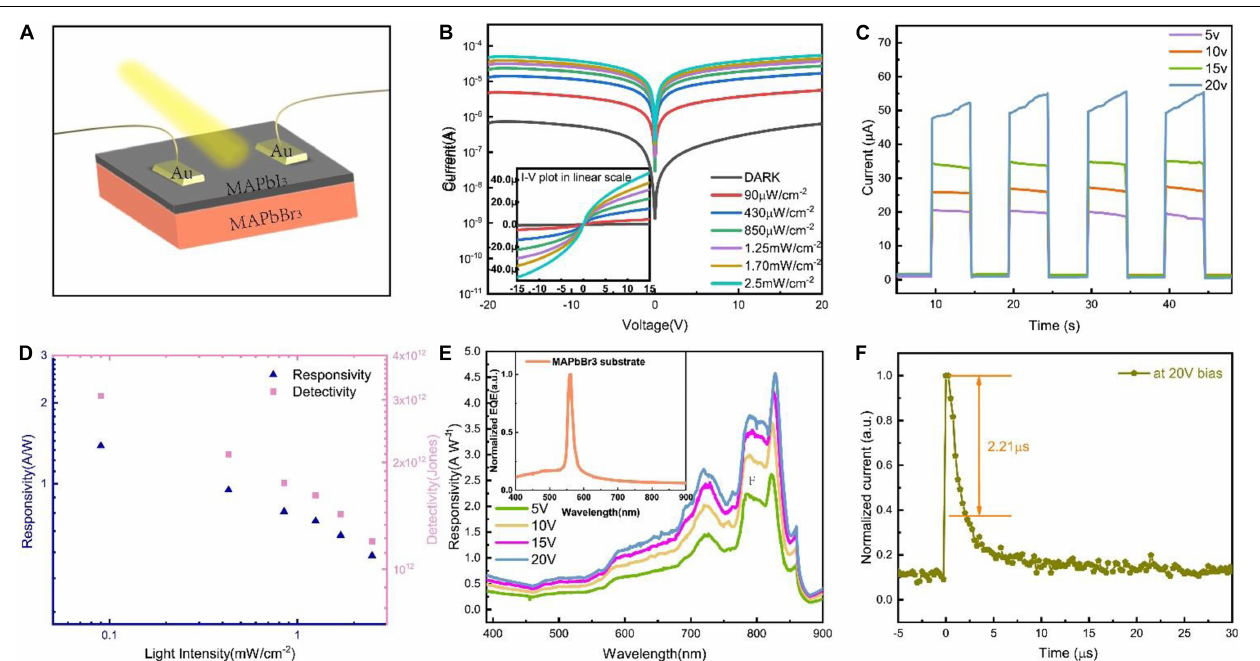
FIGURE 3 | (A) Schematic illustration of our photodetector and the incident light. The size of the photodetector is 0.025 cm 2 . (B) I-V curves of our photodetector under dark and various light illumination intensities from 90 µ W cm − 2 to 2.5 mW cm − 2 . The wavelength of incident light is 670 nm. (C) Temporal response of the photodetector at different voltage bias at 670 nm under 90 µ W cm − 2 light illumination intensity. (D) Plots of responsivity and detectivity of our photodetector at 20 V bias as a function of light intensity at 670 nm. (E) Responsivity at various incident light wavelength from 400 to 900 nm under different voltage bias and the normalized External Quantum Efficiency (EQE) of MAPbBr 3 single crystal. (F) Response time at 20 V bias under a 6 ns pulsed